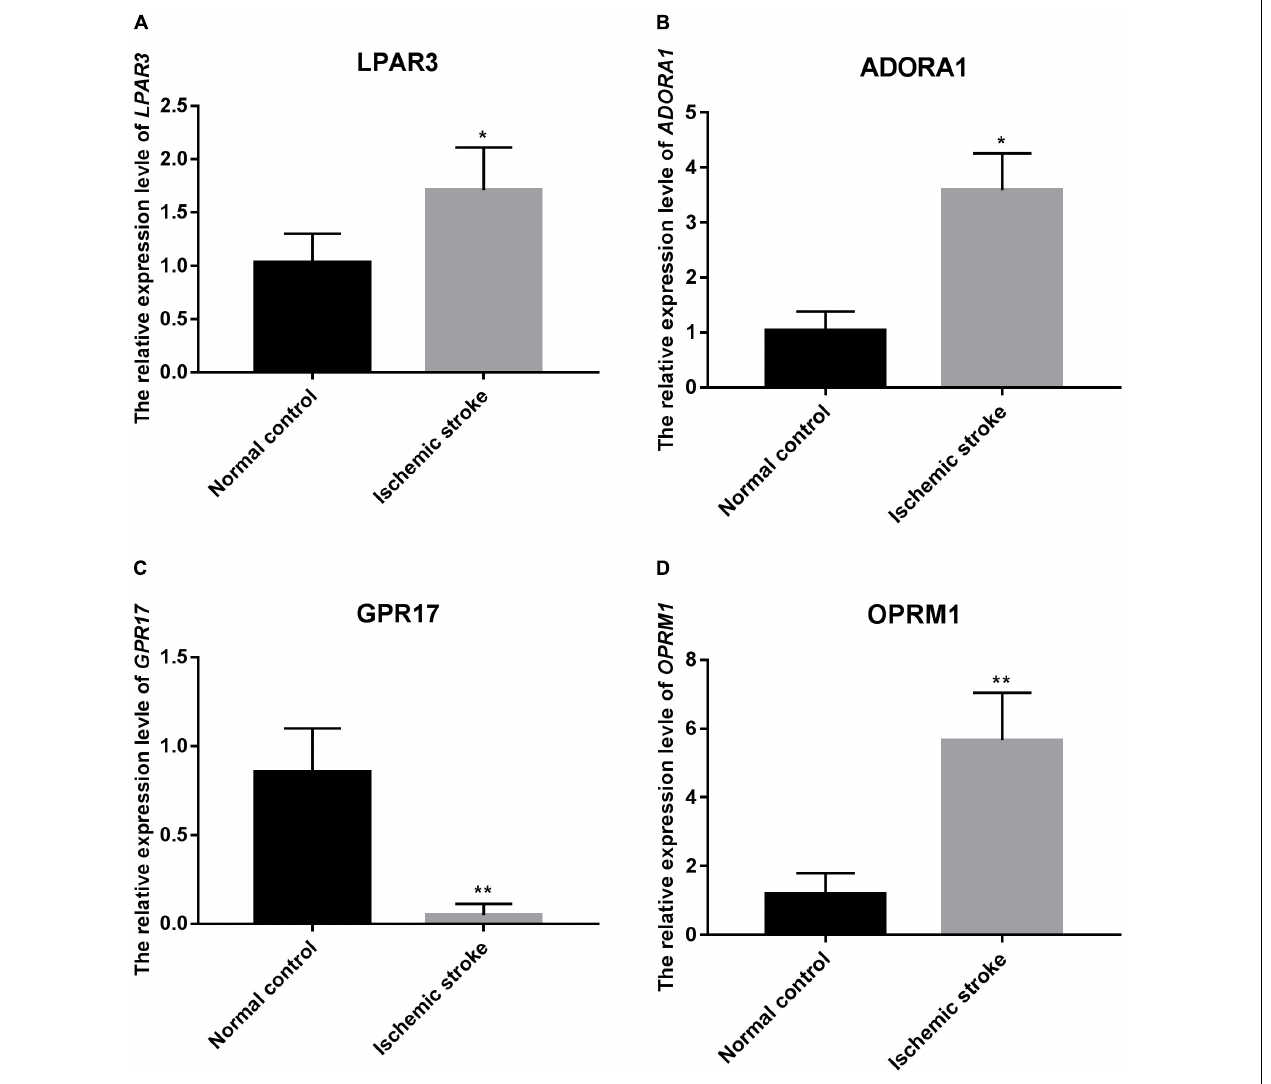
FIGURE 8 | The relative expression level of LPAR3 (A) , ADORA1 (B) , GPR17 (C) , and OPRM1 (D) . * represents p < 0.05, and ** represents p <